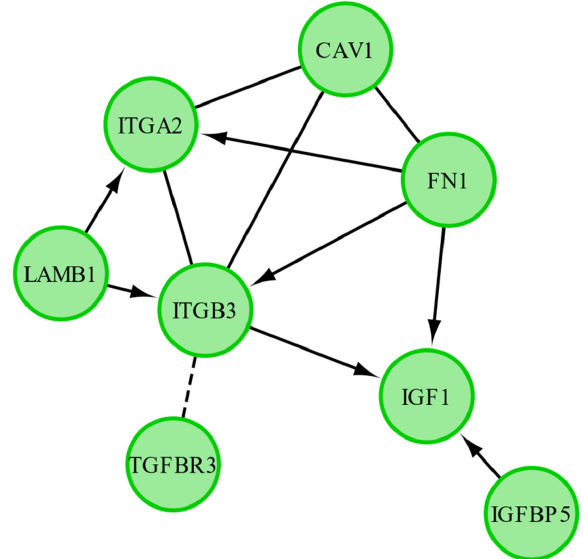
Figure 7. Functional interaction (FI) between 10 most upregulated and 10 most downregulated genes that belong to “cell development”, “cell differentiation” and “cell morphogenesis” GO BP terms. In the figure “ → ” stands for activating/catalyzing, “—” stands for FIs extracted from complexes or inputs, and “---” stands for predicted FIs.